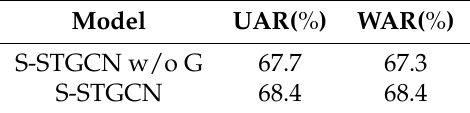
Table 3. Comparison for the use of the gating